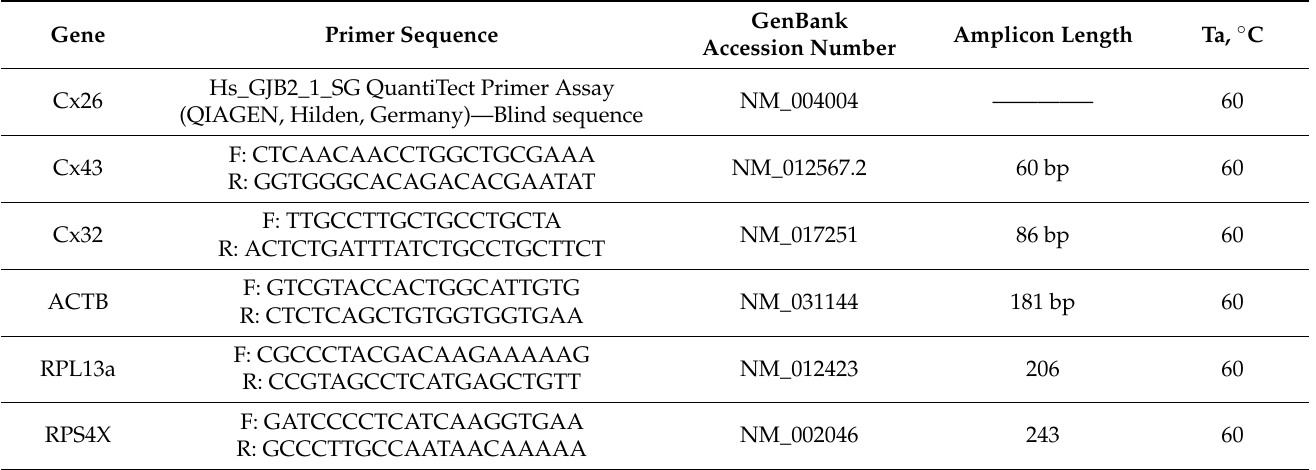
Table 1. Details of gene specific primers used in real-time PCR